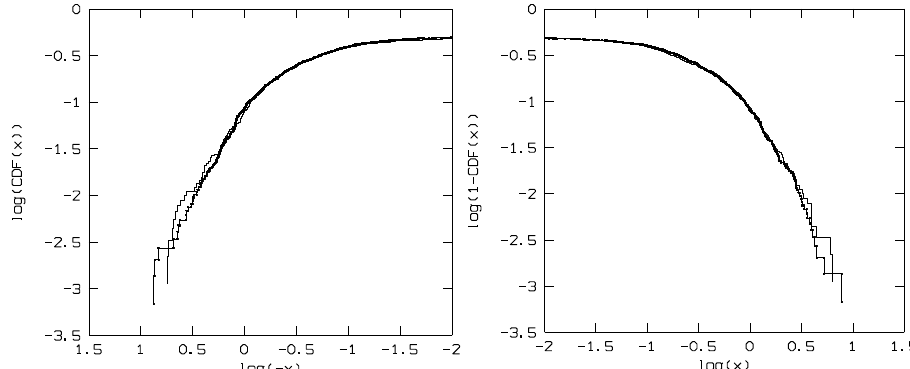
Figure 3. Double logarithmic graphs of CDFs of PKS 2255-282 and 3C446. The thin line is the CDF of PKS 2255-282, the thick line is the CDF of 3C446. The distributions of PKS 2255-282 and 3C446 are similar at the 94.3 percent level.